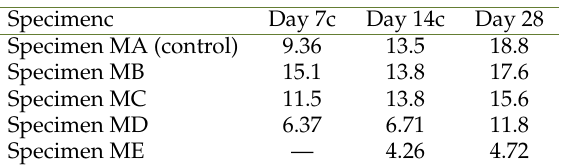
Table 6. Compressive strength of the mortar mix (in MPa)